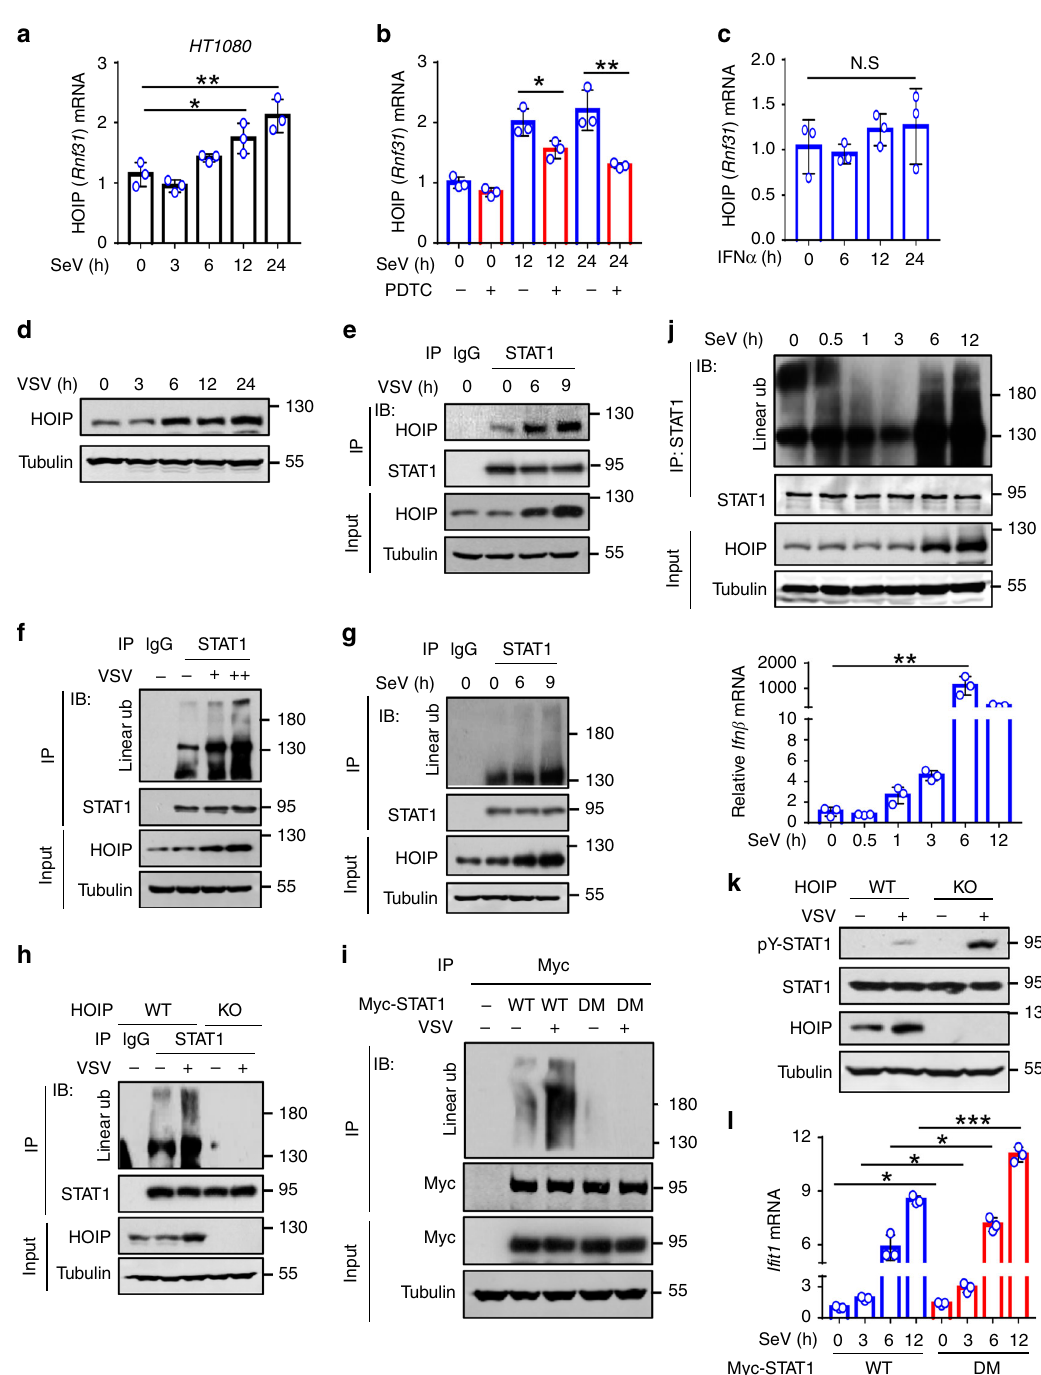
Fig. 6 Viruses upregulate HOIP and STAT1 linear ubiquitination. a RT-qPCR analysis of HOIP mRNA in HT1080 cells challenged with SeV (MOI = 1.0) for the indicated times. b RT-qPCR analysis of HOIP mRNA in HT1080 cells infected with SeV (MOI = 1.0) and then treated with a NF- κ B inhibitor PDTC (10 µ M) as indicated. c RT-qPCR analysis of HOIP mRNA in HT1080 cells stimulated with IFN α (1000 IU/ml) as indicated. d Western blot analysis of HOIP proteins in HEK293T cells infected with VSV (MOI = 0.1) as indicated. e Immunoprecipitation analysis of the interaction between HOIP and STAT1 in 2fTGH cells infected with VSV (MOI = 0.1) as indicated. f Immunoprecipitation analysis of linear ubiquitination of STAT1 in 2fTGH cells infected with VSV (MOI = 0.1 and 0.5) for 9 h. g Immunoprecipitation analysis of linear ubiquitination of STAT1 in HT1080 cells infected with SeV (MOI = 1.0) as indicated. h Immunoprecipitation analysis of linear ubiquitination of STAT1 in HOIP-WT or HOIP-KO HEK293T cells infected with or without VSV (MOI = 0.1) for 9 h. i Immunoprecipitation analysis of linear ubiquitination of STAT1 in HEK293T cells transfected with Myc-STAT1 (WT or DM) and then infected with VSV (MOI = 0.1) as indicated. j Immunoprecipitation analysis of linear ubiquitination of STAT1 and RT-qPCR analysis of Ifn β mRNA in 2fTGH cells infected with SeV for the indicated times. k Western blot analysis of pY-STAT1 in HOIP-WT or HOIP-KO HEK293T cells infected with VSV (MOI = 0.1) for 12 h. l RT- qPCR analysis of I fi t1 mRNA in U3A cells transfected with Myc-STAT1 (WT or DM) and then infected with SeV (MOI = 1.0) as indicated. N.S., not signi fi cant ( p > 0.05) and * p < 0.05, ** p < 0.01, *** p < 0.001 (two-tailed unpaired Student ’ s t test). Data are shown as mean and s.d. of three biological replicates ( a – c , l ), or are representative of three independent experiments ( d – k